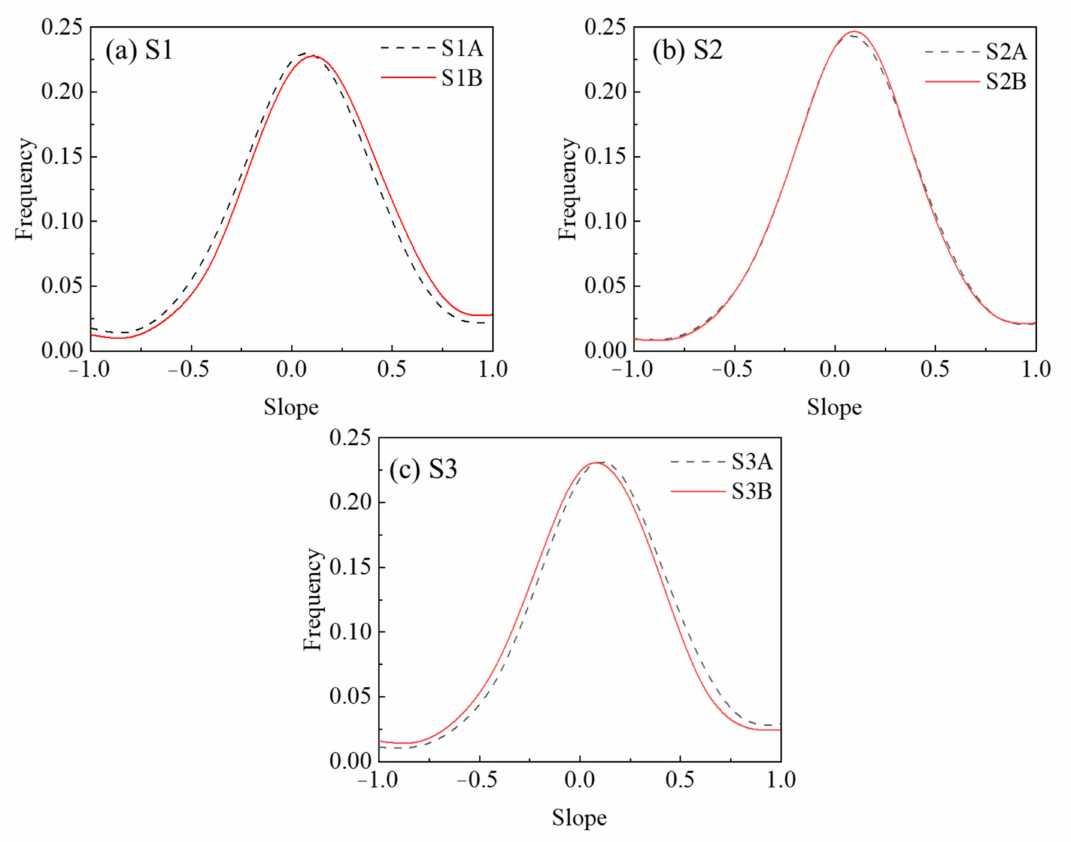
Figure 6. Distribution of surface